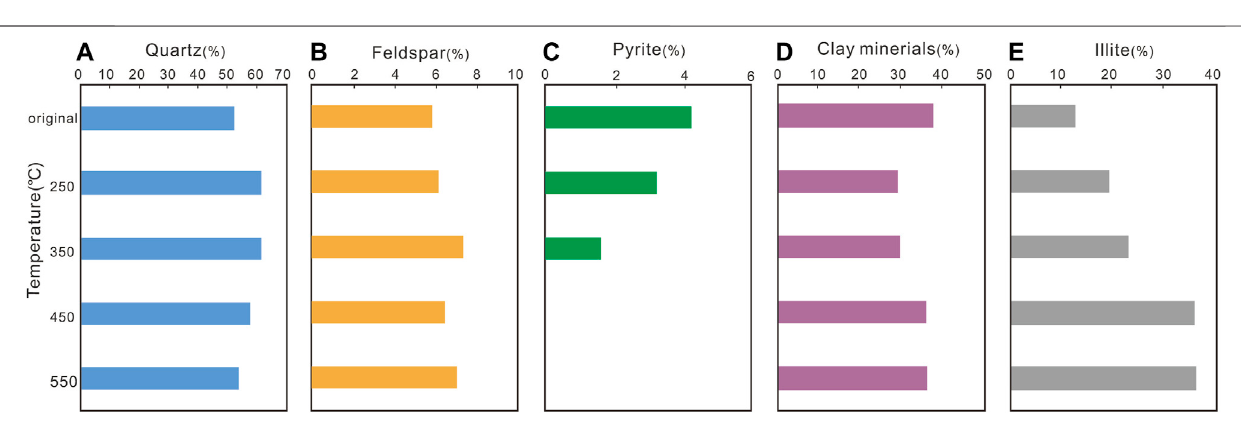
FIGURE 3 | Changes of mineral content at different temperatures. (A) -Quartz, (B) -Feldspar, (C) -Pyrite, (D) -Clay minerals, (E) -Illite.